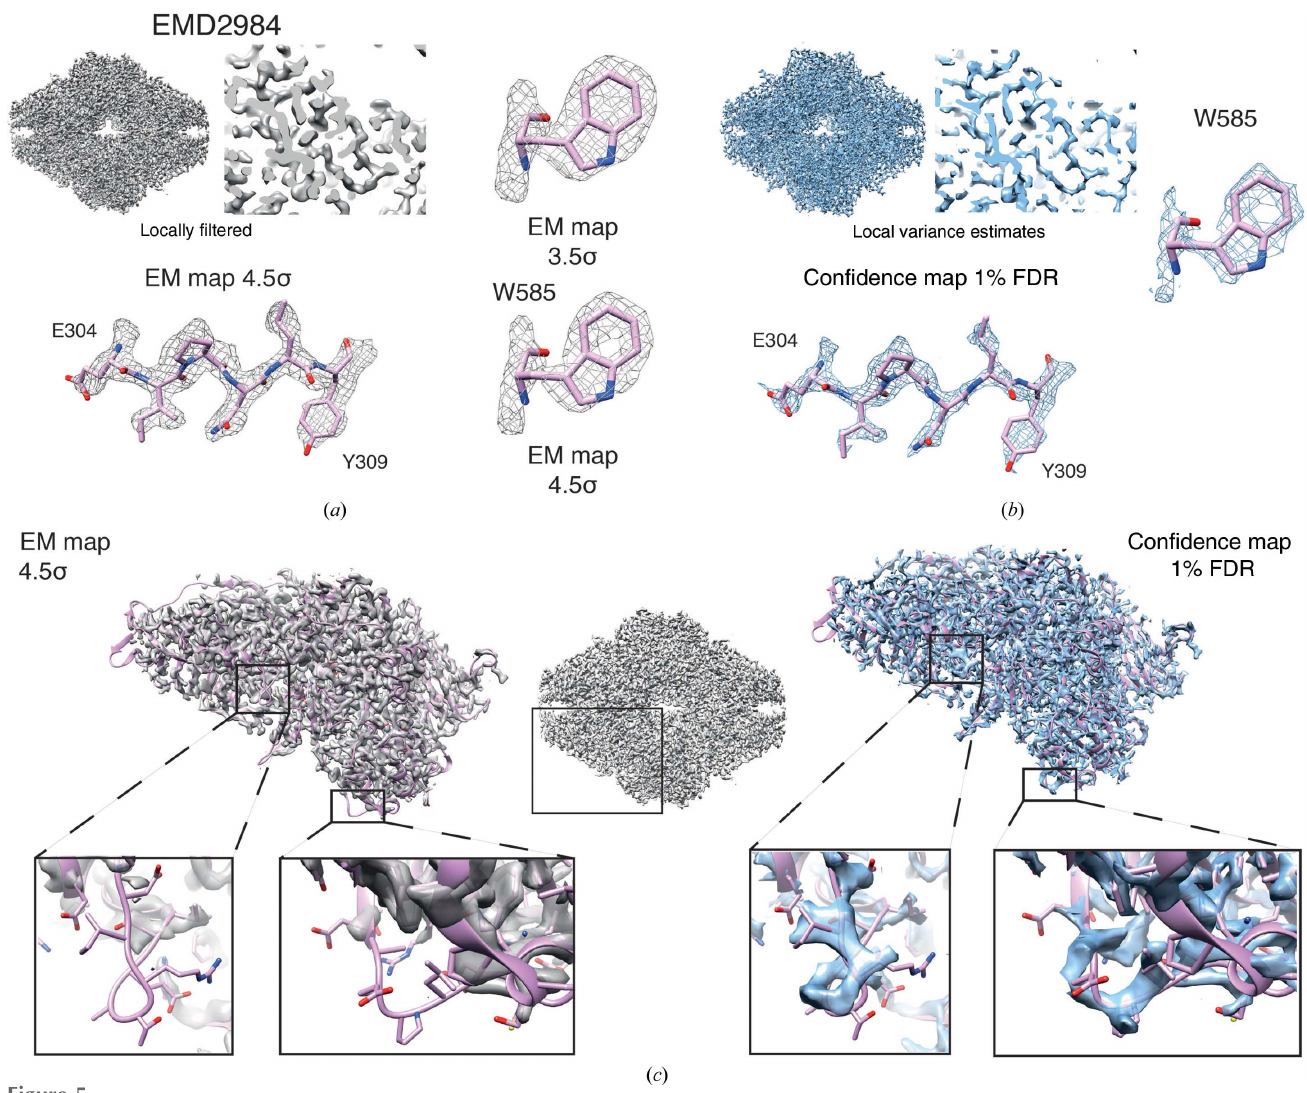
Figure 5 Confidence maps benefit from local SNR adjustment based on local resolution. ( a ) Locally filtered (cid:5) -galactosidase (EMD-2984) cryo-EM map (gray) displayed at a 4.5 (cid:2) threshold (left) and ( b ) confidence map (blue) including signal-to-noise adjustment based on local resolution at a 1% FDR threshold (right) in side view and cross-section. High-resolution features such as Glu304–Glu398 and holes in the aromatic rings of Trp585 in the 3.5/4.5 (cid:2) - thresholded cryo-EM map ( a ) in comparison with the 1% FDR confidence map ( b ). ( c ) Comparison of density features from peripheral loop regions not covered by density in the locally filtered cryo-EM map (left) compared with the 1% FDR confidence map that shows densities for the respective